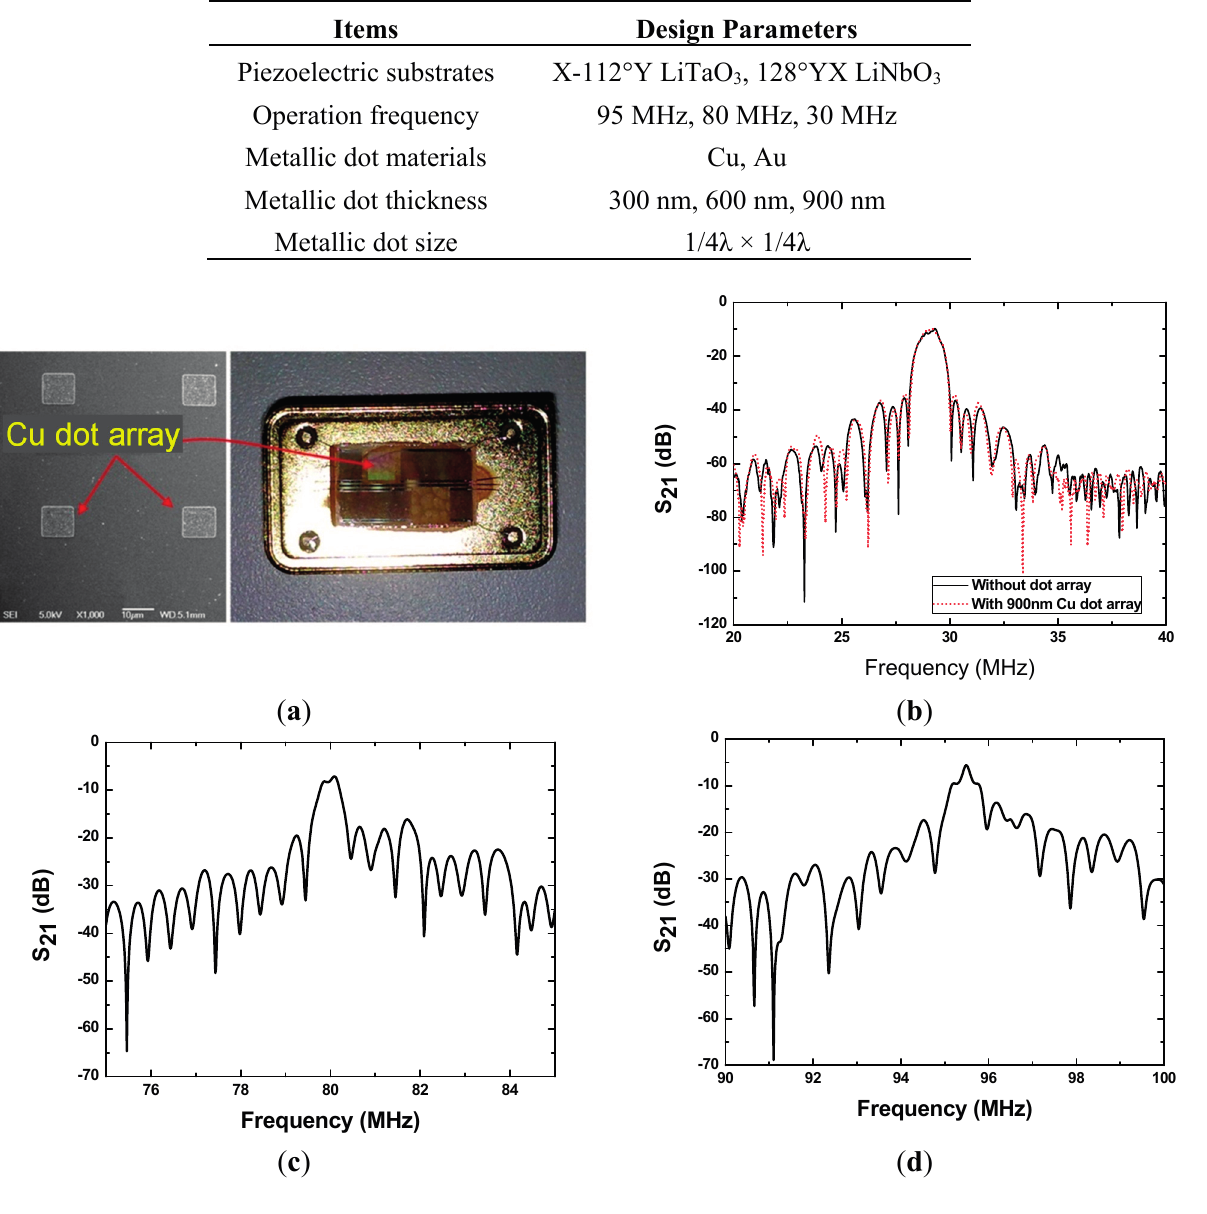
Figure 5. Developed SAW sensor chip ( a ), measured S 21 of 30 MHz SAW device ( b ), and 80 MHz SAW device ( c ), and 95 MHz SAW device ( d